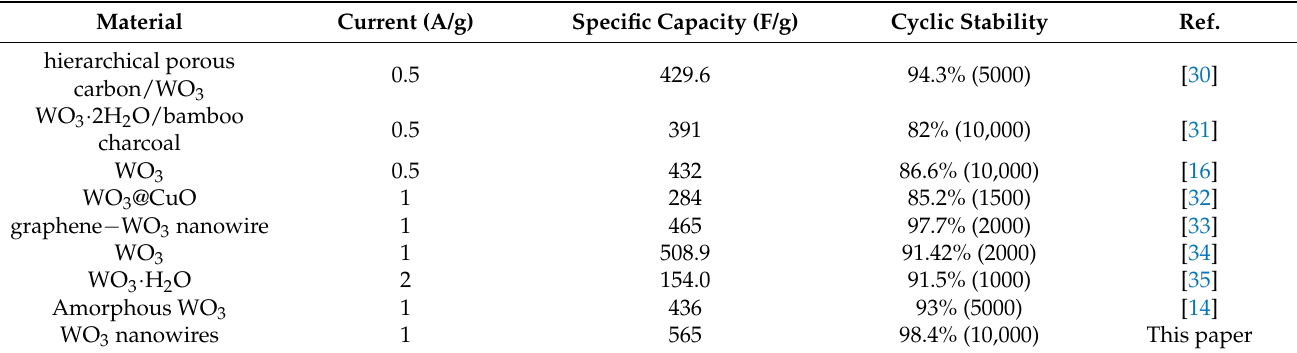
Table 2. Comparison of electrochemical